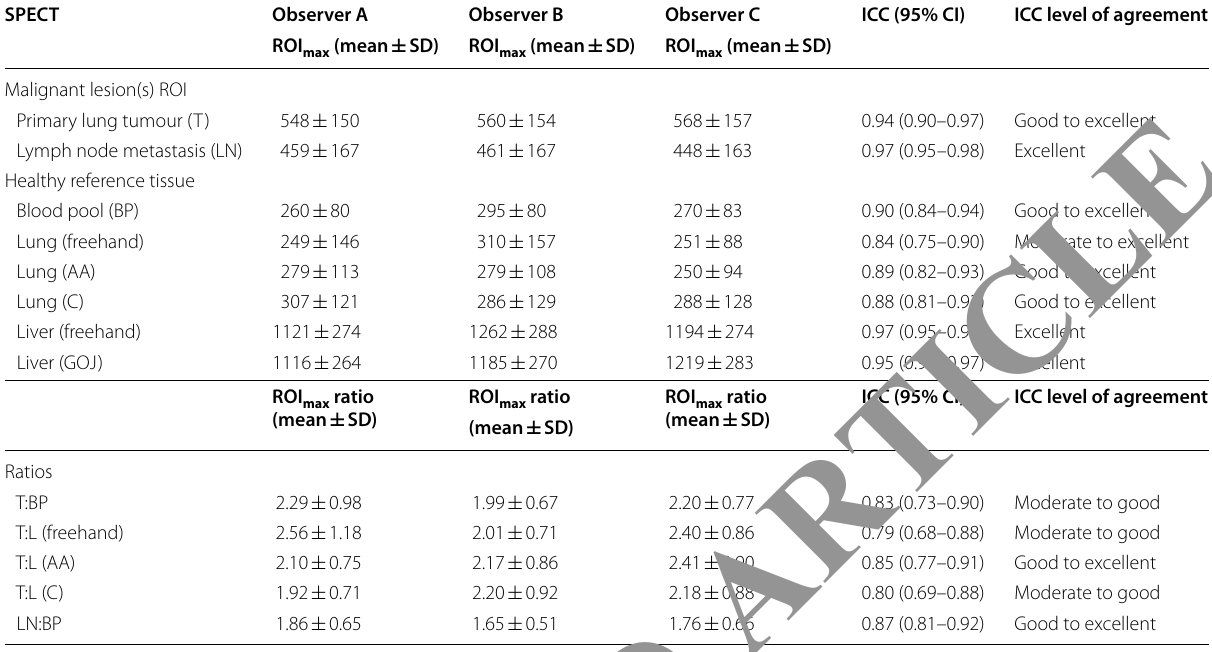
Malignant lesion and healthy tissue reference measurements (ROI max ; mean their 95% confidence interval (CI) and descriptive ICC level of agreement AA aortic arch, BP blood pool, C carina, CI confidence interval, ICC intraclass correlation coefficient, GOJ gastroesophageal junction, L lung, LN lymph node metastasis, ROI region of interest, T primary lung